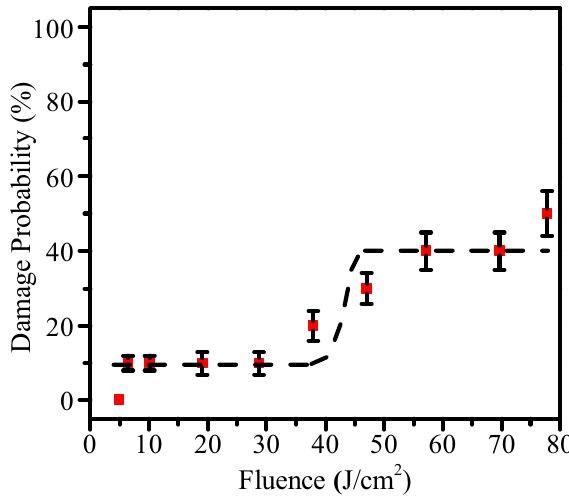
Figure 2. Damage probability curves of Al 2 O 3 /SiO 2 coatings.